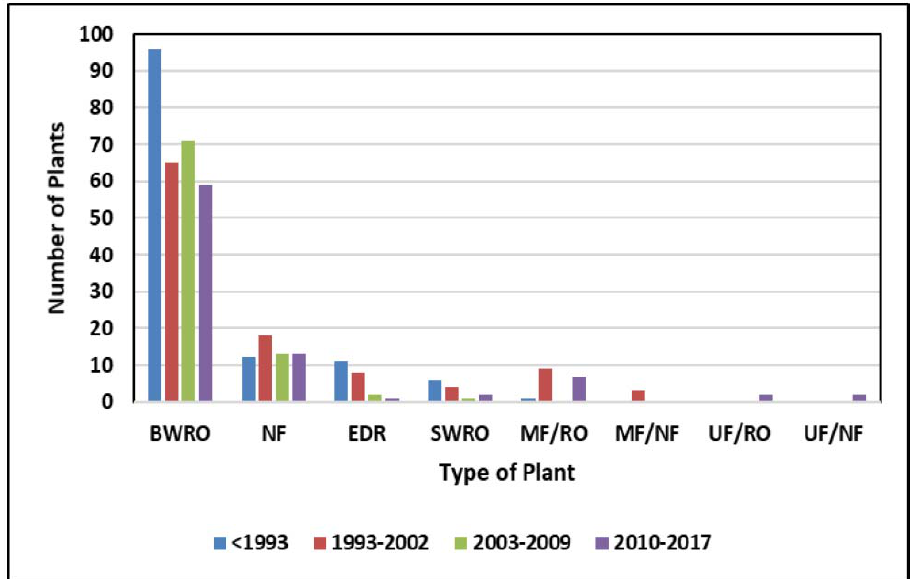
Figure 2. Number of desalination plants operating in the United States in 2010 [19].